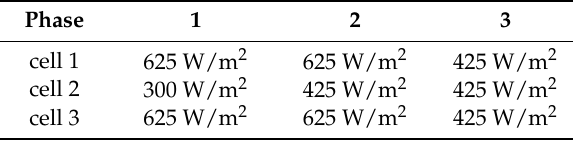
Table 3. Non ‐ uniform case: PV panel irradiance values. Table 3. Non-uniform case: PV panel irradiance